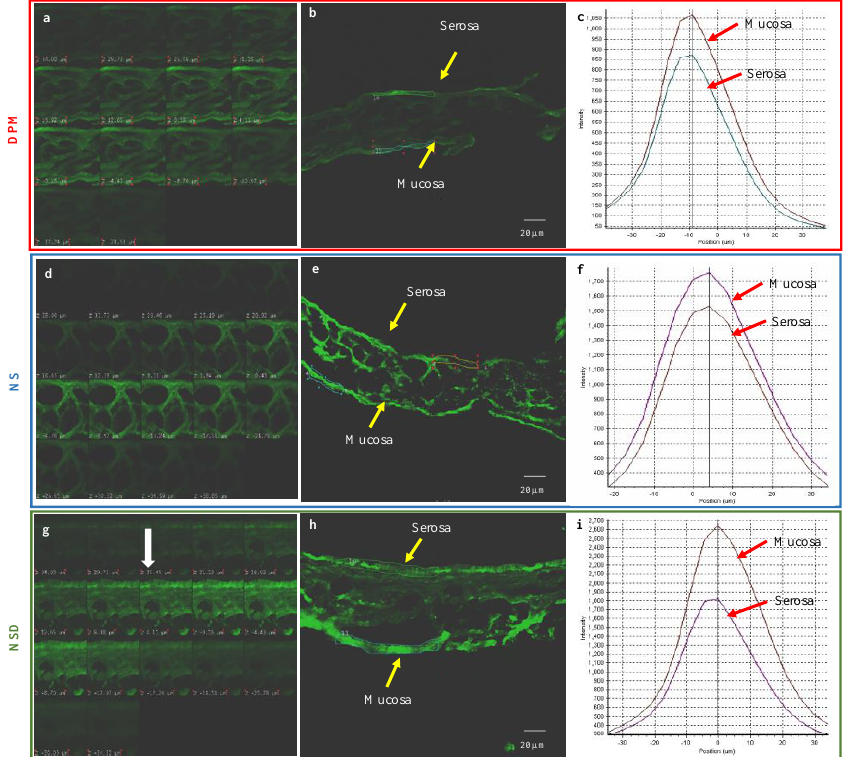
Figure 6. CLSM images of a transverse section of the jejunum segment of the everted gut sac. Images ( a – c ) represen DPM, images ( d – f ) represent NS and images ( g – i ) represent NSD. Images ( a , d , g ) depict the Z-stack of the sac in increasing depth. Images ( b , e ), and h represent the selected images of optimal intensity. Images ( c , f , i ) represent the measured intensity at serosal and mucosal side.